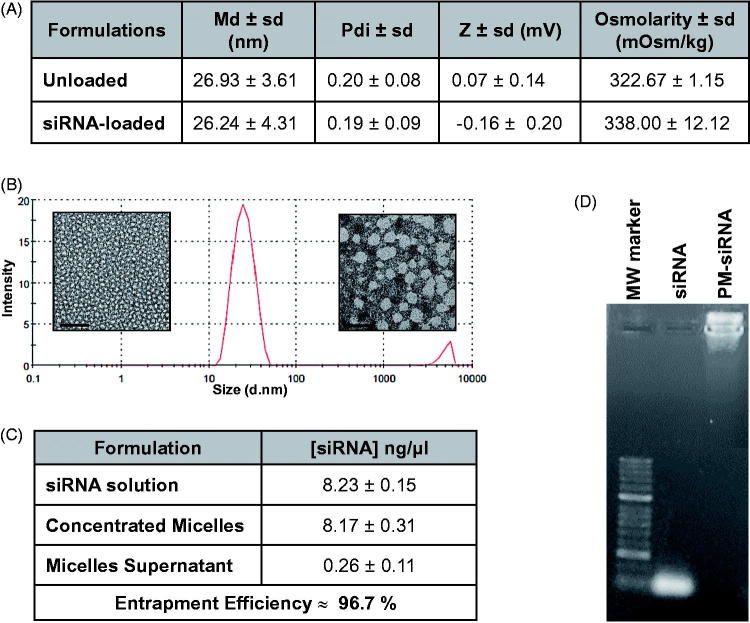
Physicochemical characterization of F127 PM for siRNA delivery. (A) Summary of size, polydispersity, zeta potential and osmolarity values of PM. Results are expressed as mean ± sd (n ≥ 3). (B) mean hydrodynamic diameter distribution of PM-siControl represented trough the graph of size dispersion by intensity together with TEM images of PM at different magnifications. Scale bar represents 100 nm and 50 nm, respectively. (C) siRNA entrapment efficient determined by a spectrophotometer method. Results are expressed as mean ± sd (n ≥ 3). (D) siRNA entrapment efficient determined by agarose gel retardation assay.